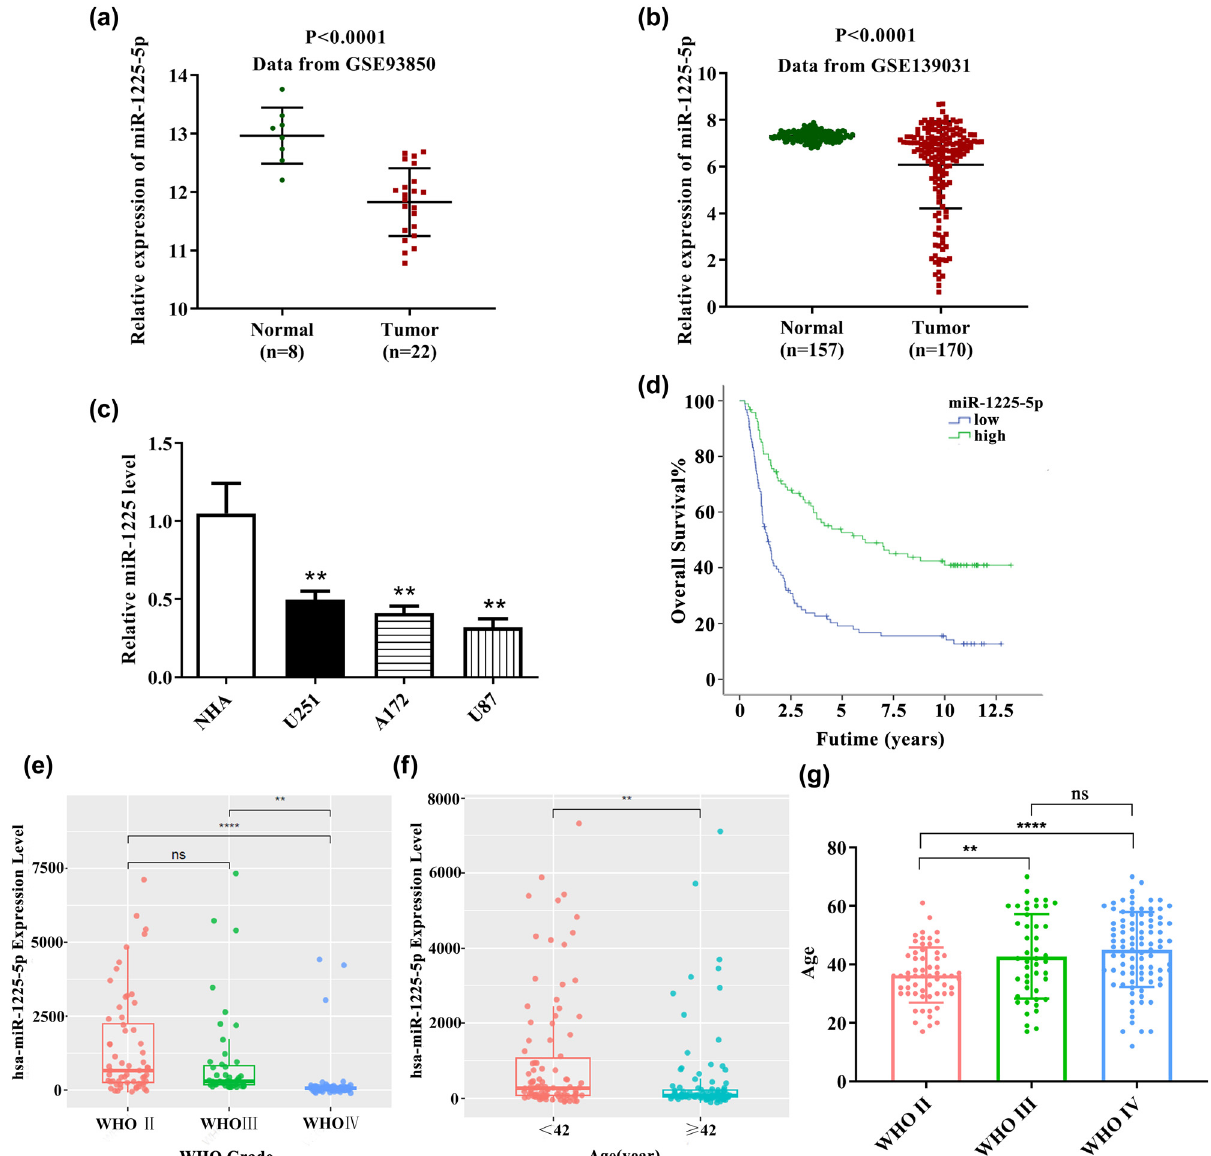
Figure 1: miR - 1225 - 5p was expressed at a low level in glioblastoma and related to WHO grade, age and prognosis. ( a ) The di ff erential expressions of miR - 1225 - 5p in glioblastoma patients ( n = 8 ) and healthy control ( n = 22 ) were analyzed based on the GEO database ( GSE93850 ) . ( b ) The data containing 170 glioblastoma patients and 157 healthy controls were downloaded from GEO database ( GSE139031